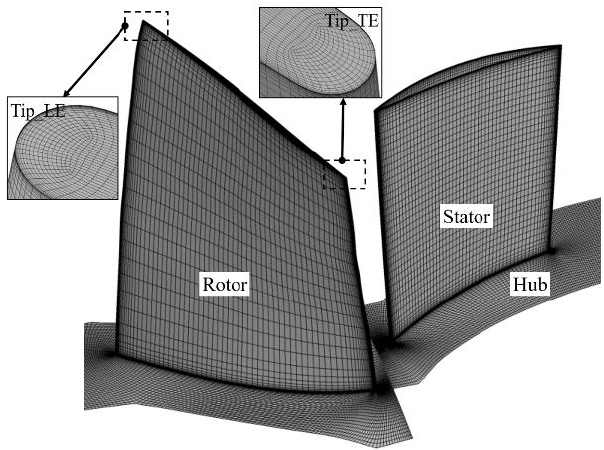
Figure 3. Computational mesh of compressor.